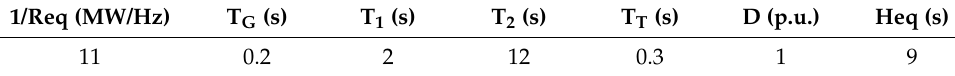
Table 3. Summarised parameters for the developed power system model.